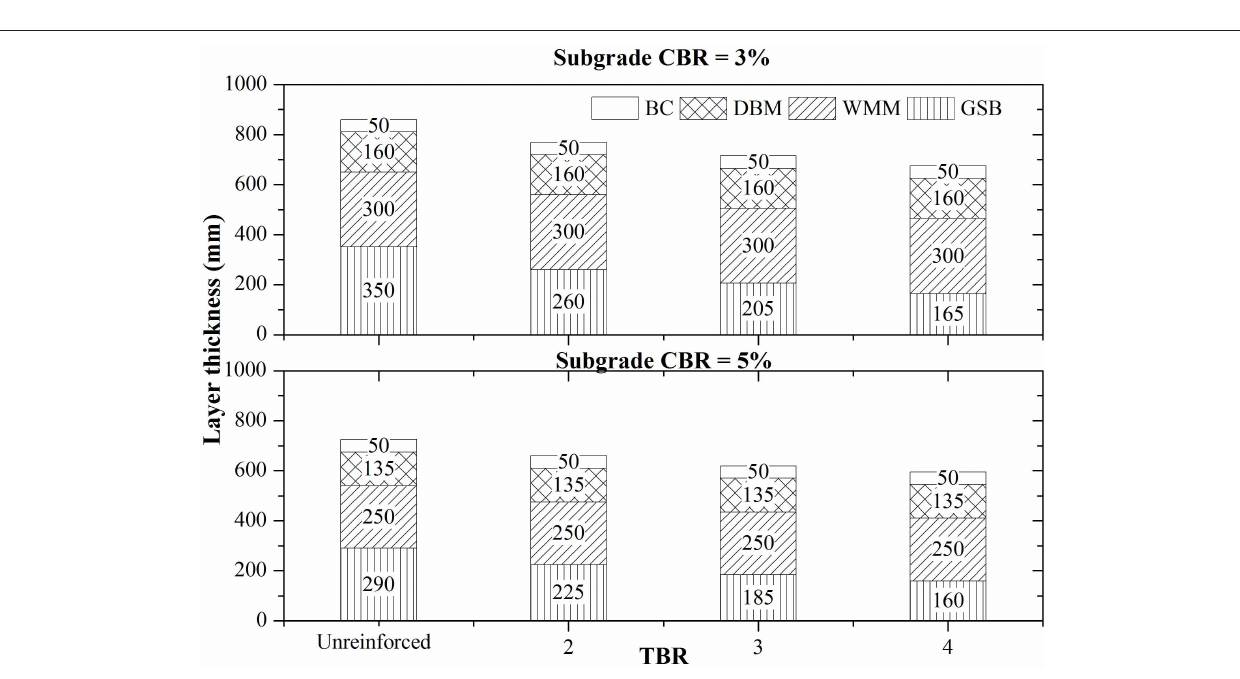
Figure 5 shows the geogrid-reinforced pavement design charts for a traffic of 100 MSA and subgrade CBRs of 3 and 5% at selected TBR values. Tables C.2.1,C.2.2 in Annex C.2 provide the